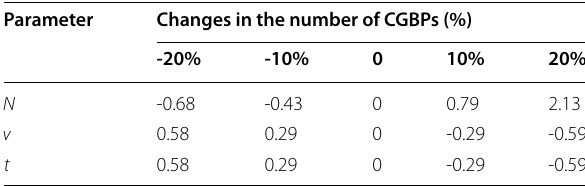
Table 7 Changes in the number of CGBPs under different parameter conditions